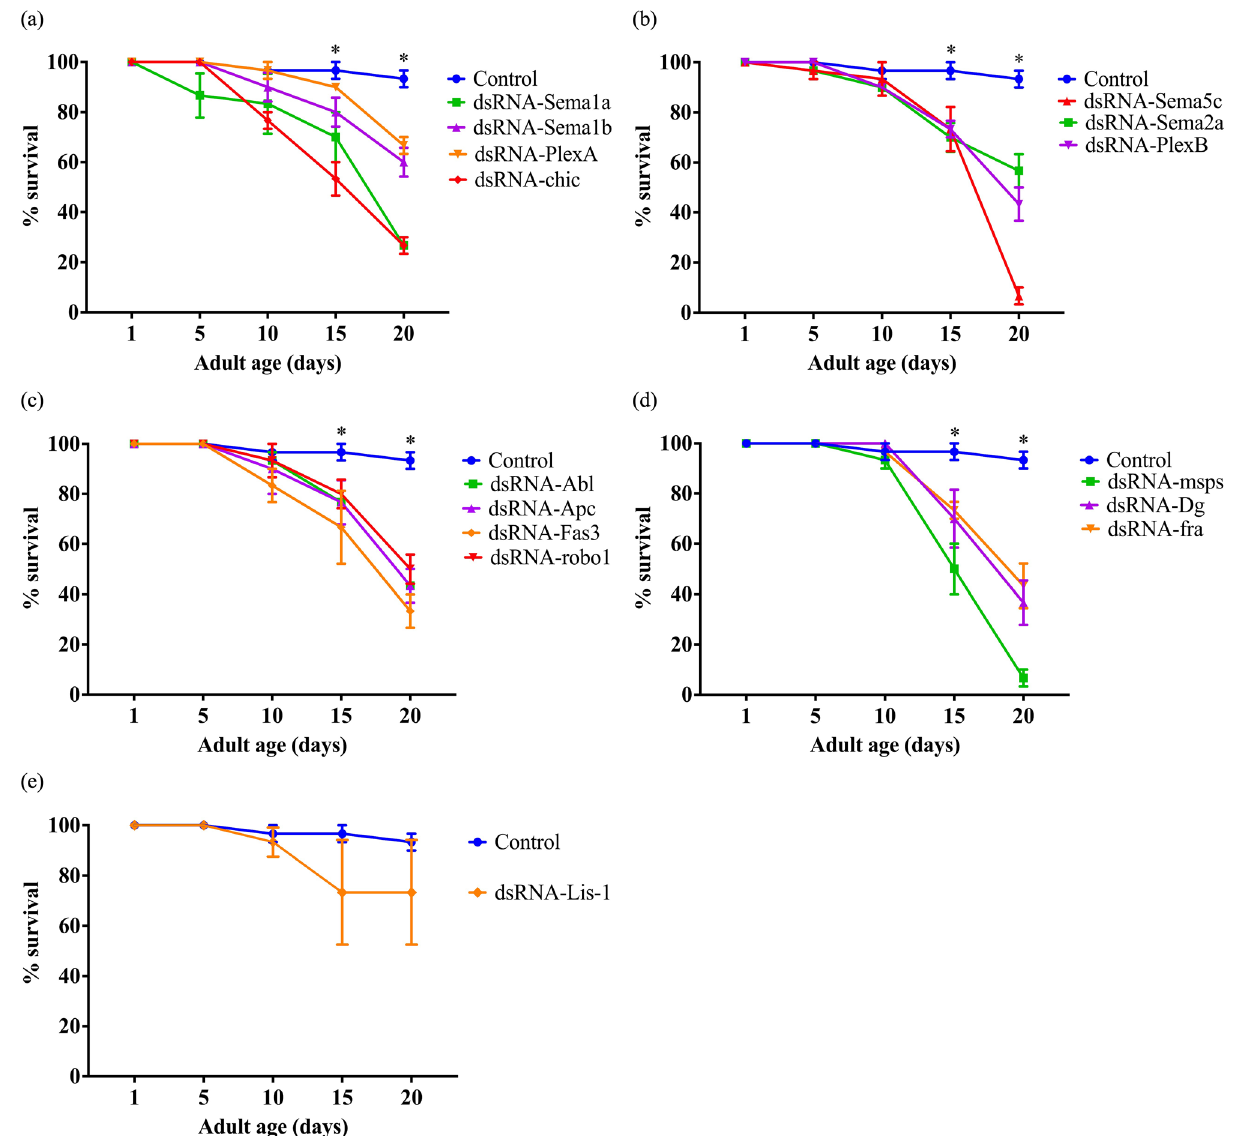
Figure 2. The TARGET system screen confirmed a reduced adult survival rate for 14 axon guidance genes knocked down. ( a – d ) Knockdown of Sema1a, Sema1b, PlexA, chic, Sema5c, Sema2a, PlexB, Abl, Apc, Fas3, robo1, msps, Dg and fra exhibited a significant reduction in the adult survival rate. ( e ) Knockdown of Lis- 1 did not show a significant effect on the adult survival rate in the TARGET screen . Data shown are mean ± SEM (p < 0.05, two-way ANOVA and Tukey’s multiple comparison tests; n = 30). ‘*’ indicates the time points when the survival of knockdowns was significantly different from that of the